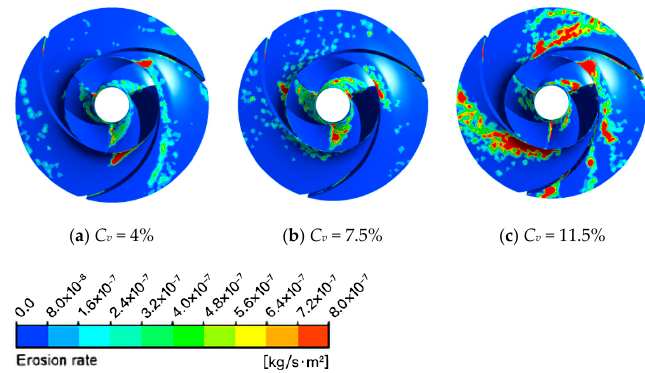
Figure 11. Wear distribution on the impeller surface.